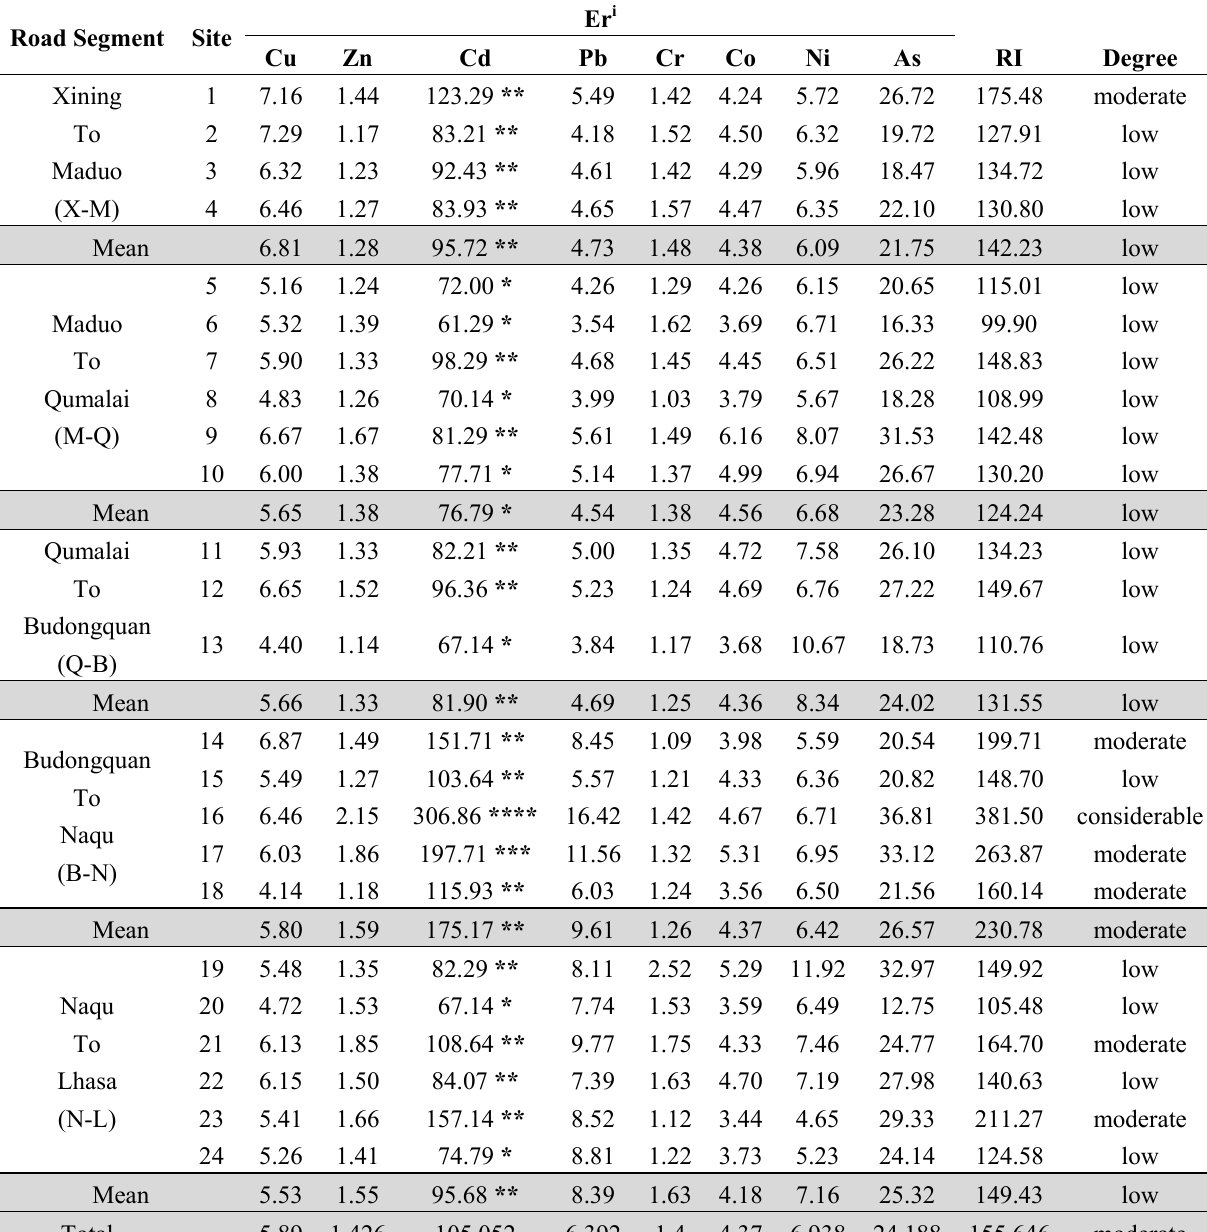
Table 4. The potential ecological risk factors and risk indices of metals based on different road segments in roadside